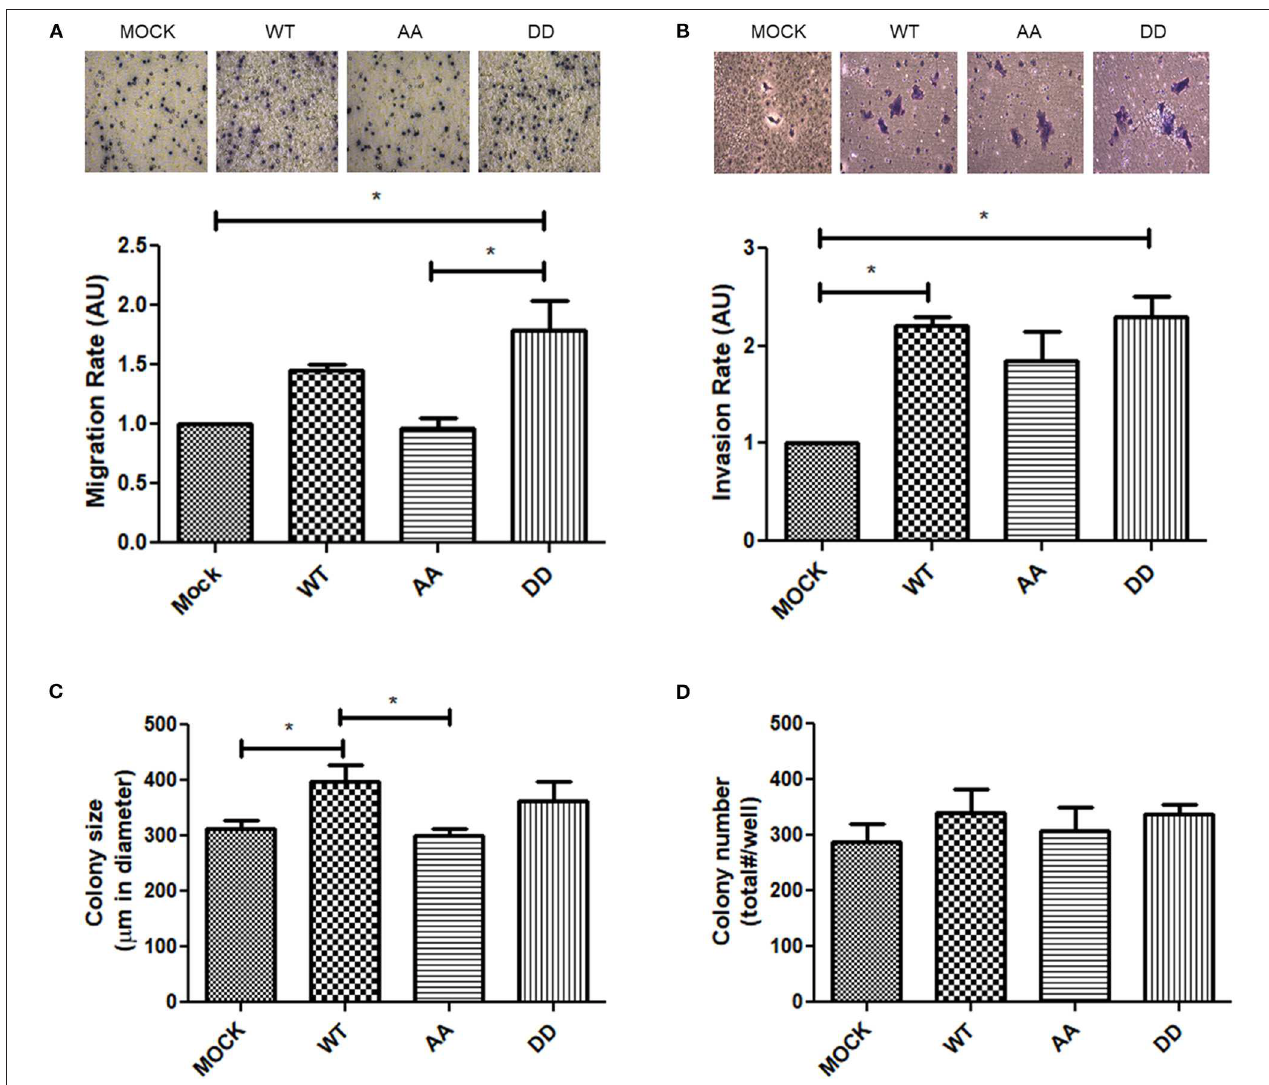
FIGURE 6 | Migration, invasion and colony-formation upon expression of ECE1c proteins in CRC cells. (A) Migration capacity of DLD-1 cells was evaluated at 8h of incubation in transwell assay. Representative images of crystal violet-stained cells at 40x magnification (upper panel). Relative quantification of migrated cells (lower panel). (B) Invasion capacity of DLD-1 cells was evaluated for 22h by matrigel assay. Representative images of crystal violet-stained cells at 40x (upper panel). Relative quantification of migrated cells (lower panel). (C,D) Colony formation was evaluated for 21 days by soft-agar assay. Number (C) and size (D) of colonies was measured with ImageJ and Micrometrics SE Premium 4 software, respectively. Graphs represent mean ± SEM. * p <